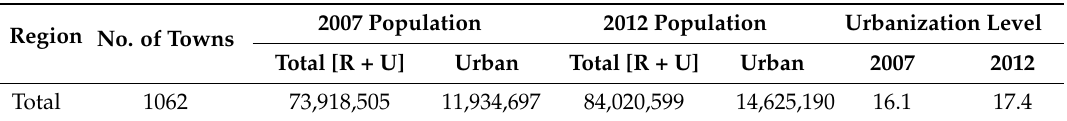
Table 2. Population of